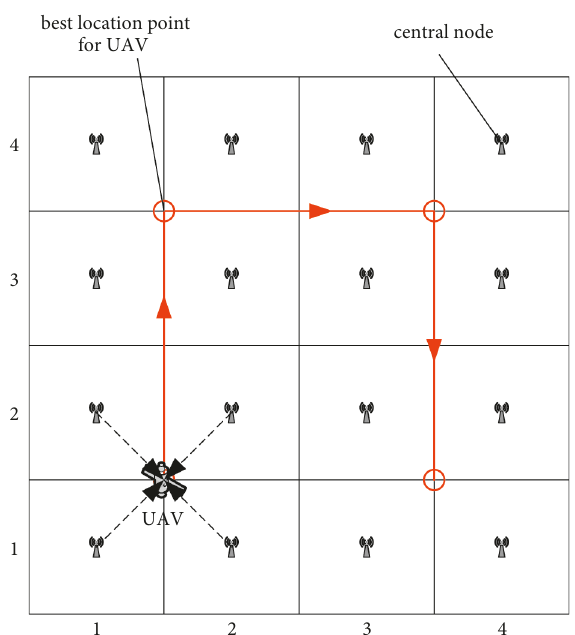
Figure 8: Physical location distribution of the central node and acquisition path of the UAV.